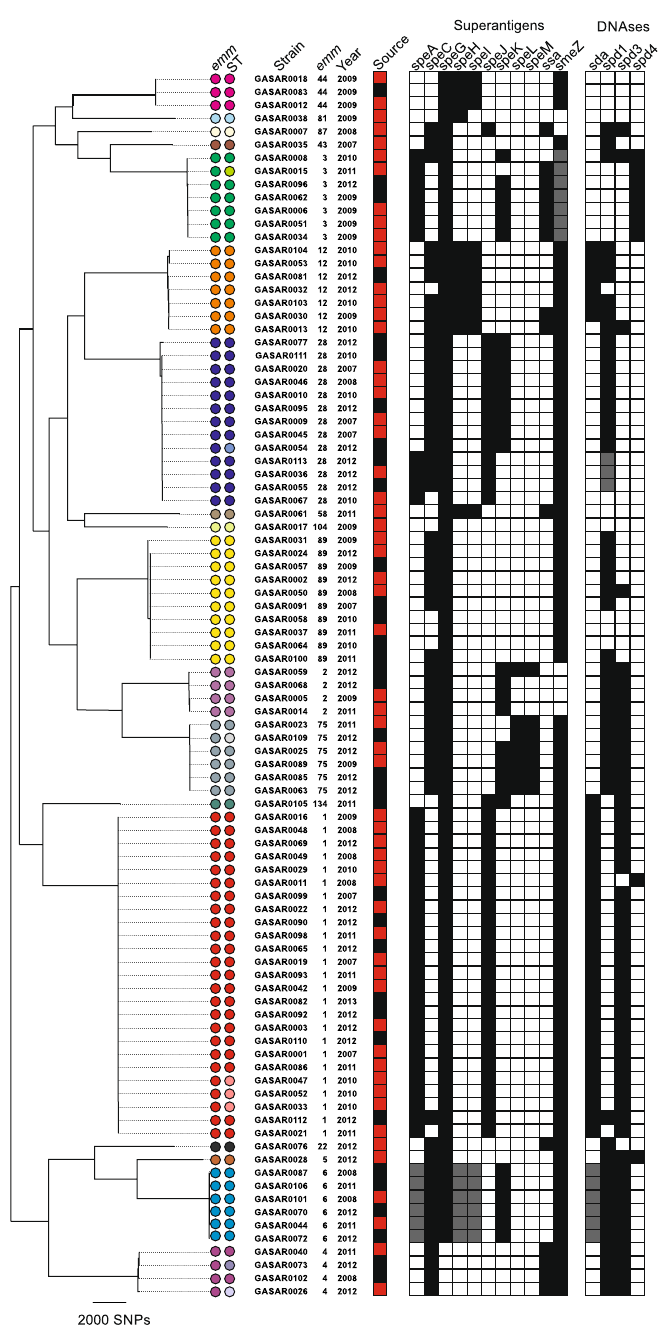
Figure 1. Core gene maximum likelihood phylogenetic analysis of all 93 isolates. All isolates clustered by emm -type and there was a broad association of variable factor complement with the emm -type. The superantigens speA , speH and speI are highlighted in grey in emm 6 strains as these are atypical variants that may not be functional. Similarly, all emm 3 strains were found to carry a non-functional smeZ gene, as previously described 16 . The DNase spd1 in three emm 28 strains is highlighted grey to indicate that it is a different variant to that found in the other emm 28 strains. Coloured circles represent emm -type/ST. The majority of emm -types were associated with a single ST type (colours of emm -type identical to colour of ST). Where an additional ST was associated with an emm -type this is represent by a different colour ST circle. emm 1 (n = 25); ST28 (red/red) or ST785 (red/pink), emm 2 (n = 4); ST55, emm 3 (n = 7); ST15 (green/green) or ST315 (green/pale green), emm 4 (n = 4); ST39 (purple/purple) or ST786 (purple/pale purple) or ST38 (purple/paler purple), emm 6 (n = 6); ST382, emm 12 (n = 7); ST36, emm 28 (n = 13); ST52 (blue/blue) or ST787 (blue/pale blue), e mm 44 (n = 3); ST367, emm 75 (n = 6); ST150 (grey/grey) or ST788 (grey/paler grey), emm 89 (n = 10); ST101. Types represented by a single isolate comprised emm 5; ST99, emm 22; ST46, emm 43; ST3 emm 58; ST176, emm 81; ST624, emm 87; ST62, emm 104; ST789, emm 134; ST790. Source; Invasive (red) or non-invasive (black) site of